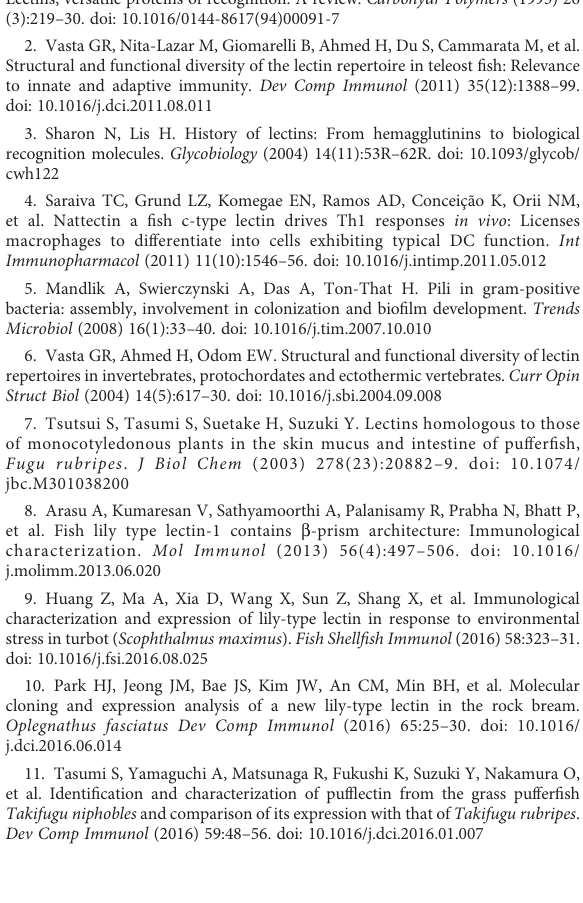
SUPPLEMENTARY FIGURE 2 Construction of a phylogenetic tree with the protein sequences of LTL. The phylogenetic tree was constructed by MEGA X with neighbor-joining method based on multiple sequence alignment by Clustal W. The reliability of each node was estimated by bootstrapping with 1,000 replications. The numbers shown at each node indicate the bootstrap values